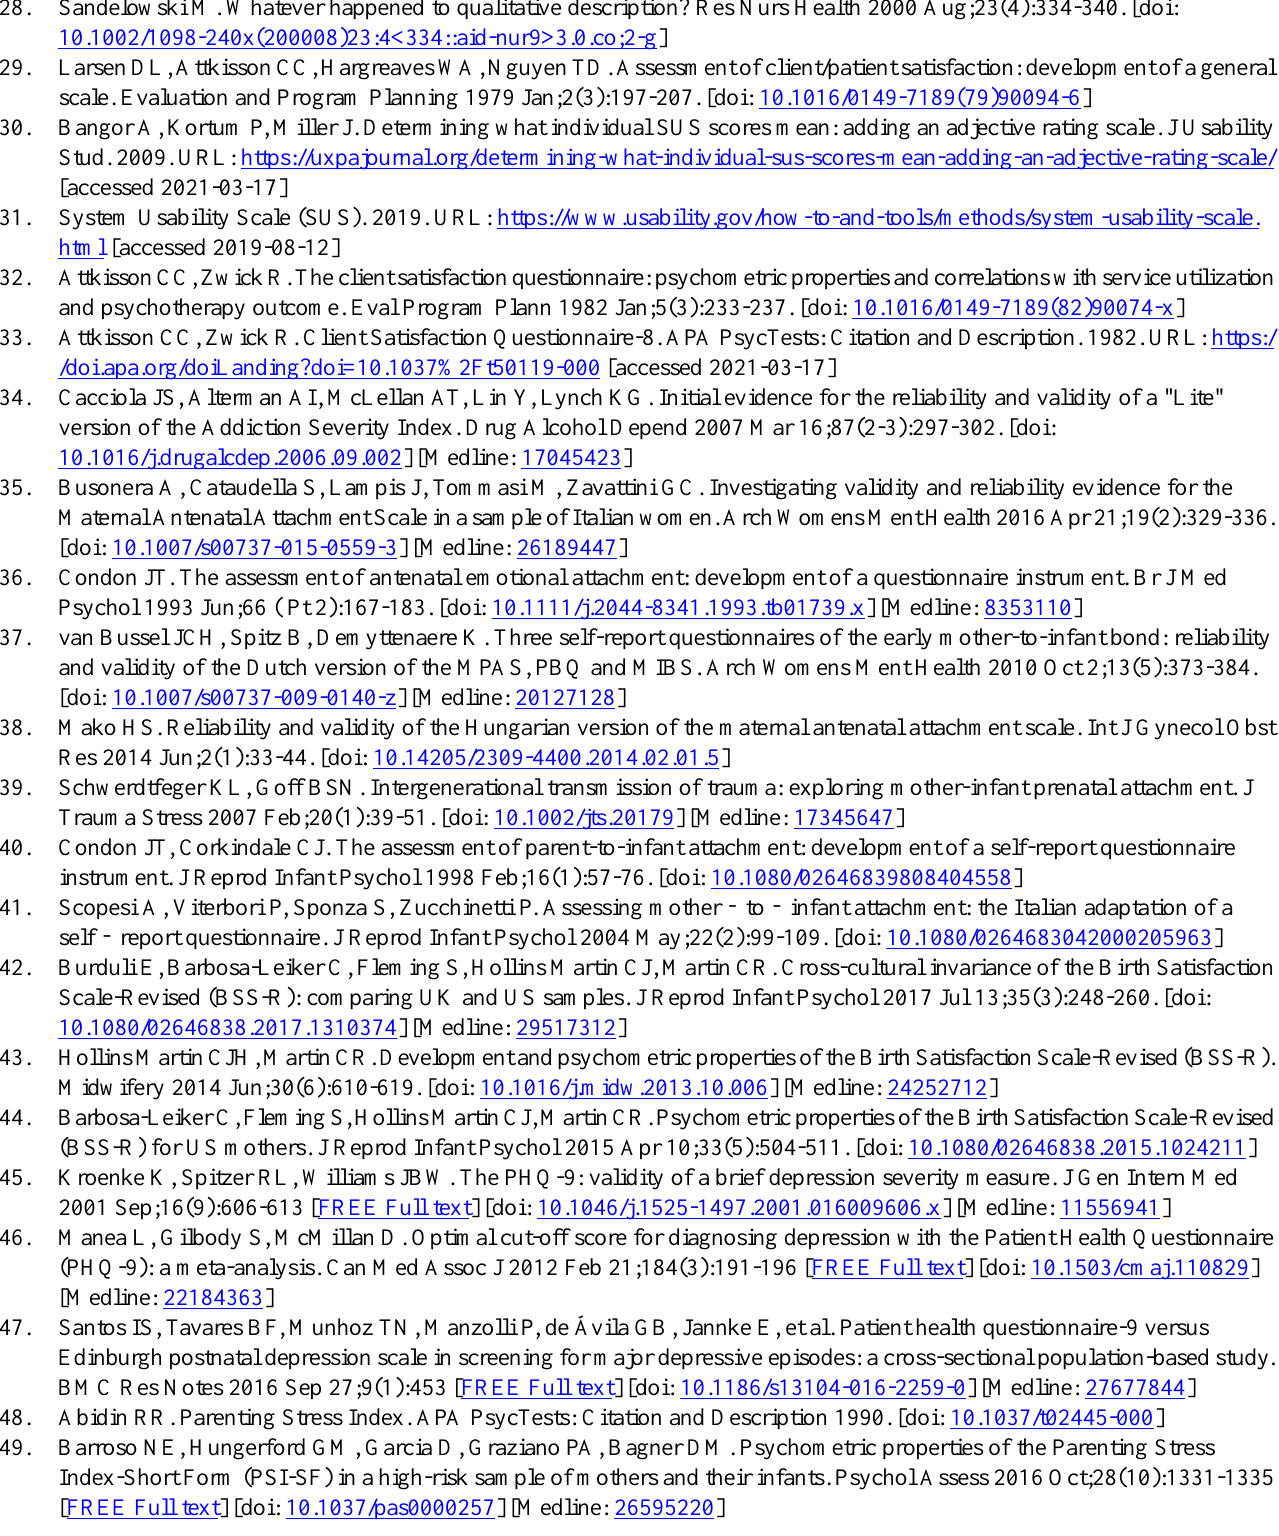
CSQ-8: 8-item Client Satisfaction Questionnaire ESC: Eat, Sleep, and Console MPAS: Maternal Postpartum Attachment Scale NAS: neonatal abstinence